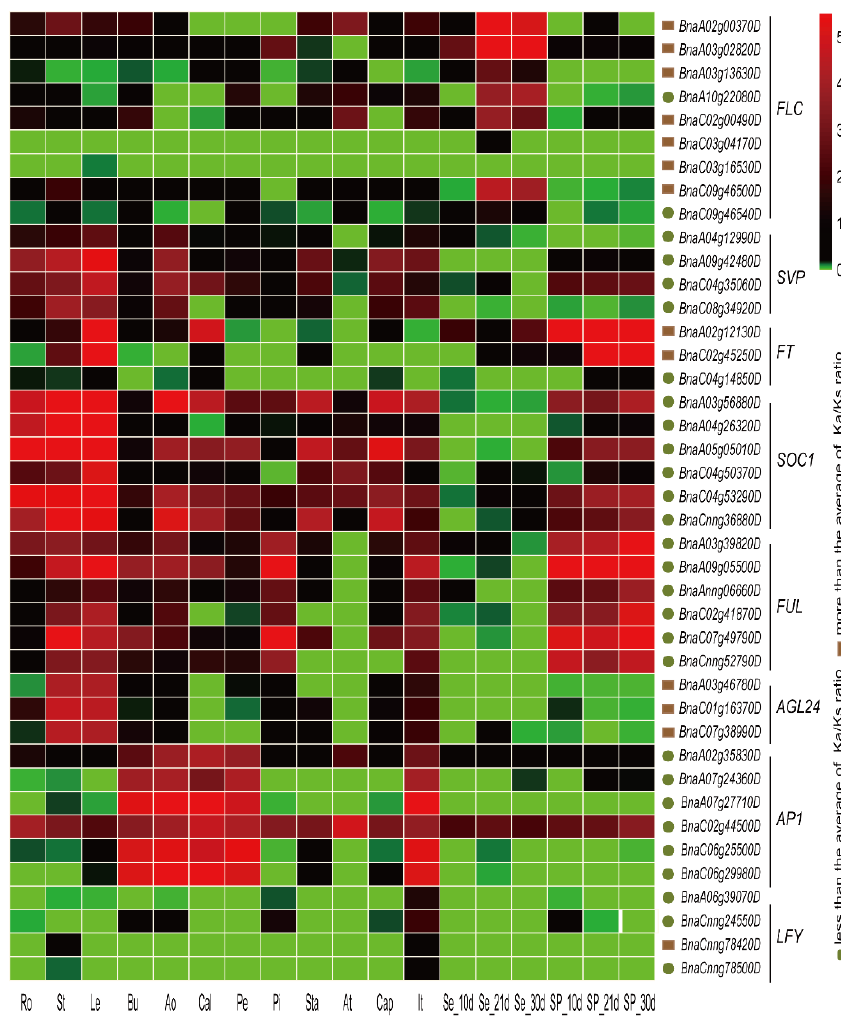
Figure 7. Organ-specific expression profiles of some flowering-time integrator genes that play crucial roles in vernalization in B. napus . The expression patterns of these genes were obtained from the RNA-seq data. The color bar at the upper right side of the figure represents Log 2 (FPKM + 1), with green representing little or no expression. The root (Ro), stem (St), leaf (Le), bud (Bu), anthocaulus (Ao), calyx (Cal), petal (Pe), pistil (Pi), stamen (Sta), anther (At), capillament (Cap), and inflorescence top (It) organs were harvested at the initial blooming stage, while seeds (Se) and silique pericarps (SP) were harvested after 10, 21, and 30 days in the field. The brown box represents high Ka/Ks gene pairs and the dark green ellipse represents low Ka/Ks gene pairs. FPKM: fragments per kilobase of exon model per million reads mapped.